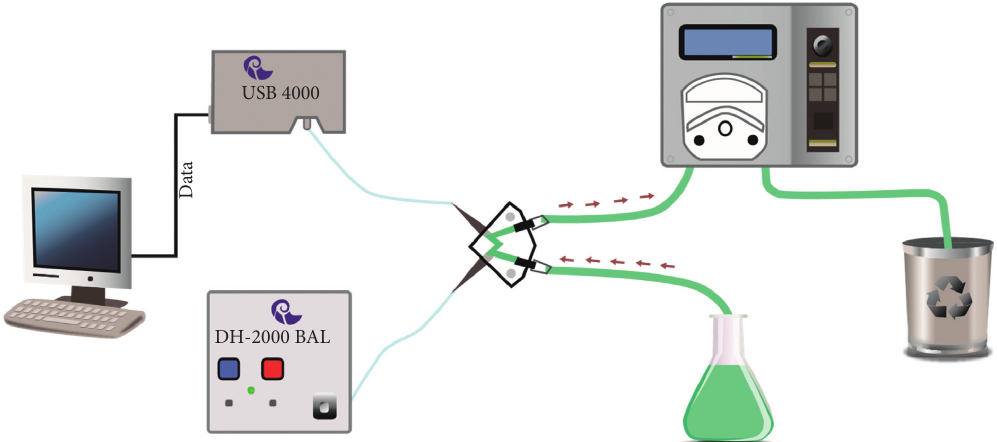
Figure 1: Experimental setup for continuous flow measurements using spectrofluorometric fiberoptic array.